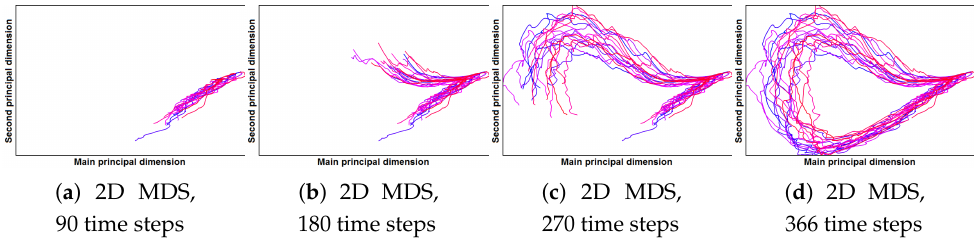
Figure 22. ( a ) Field distribution histogram for a water temperature in the local climate simulation. ( b , c ) Linked visualizations of the distribution of appearance for the selected in ( a ) field values.